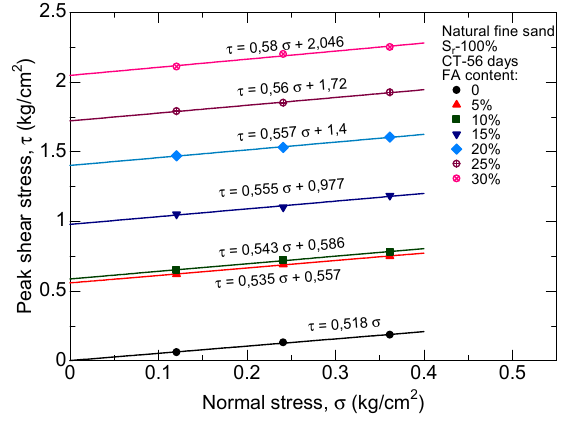
Figure 3. Shear strength parameters.